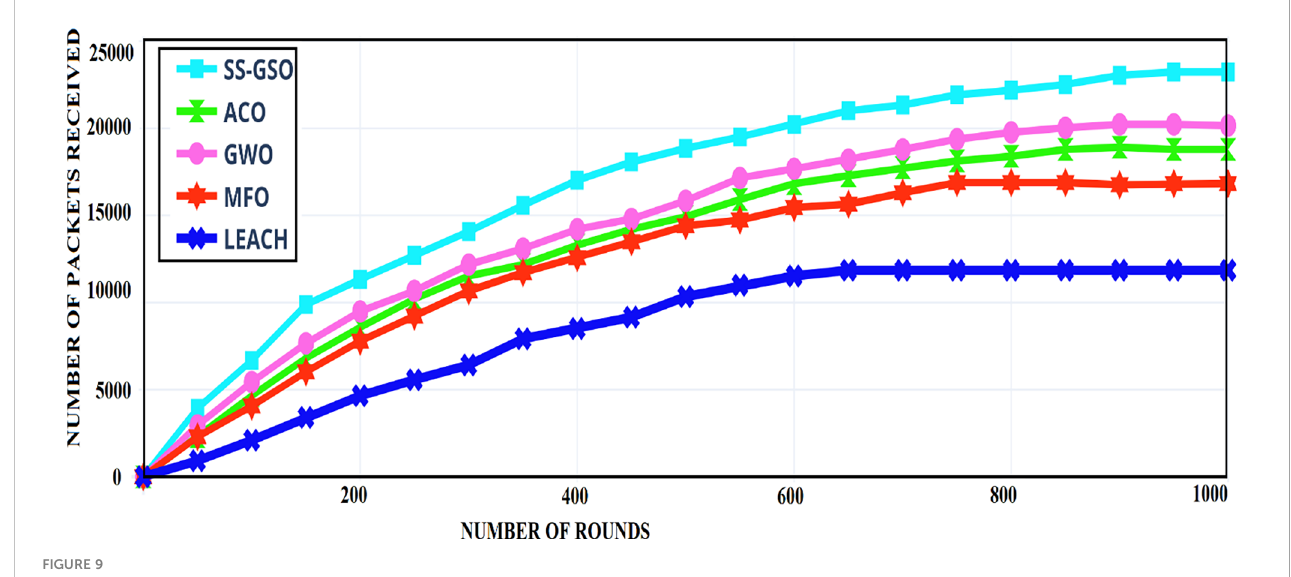
FIGURE 9 Total packet received